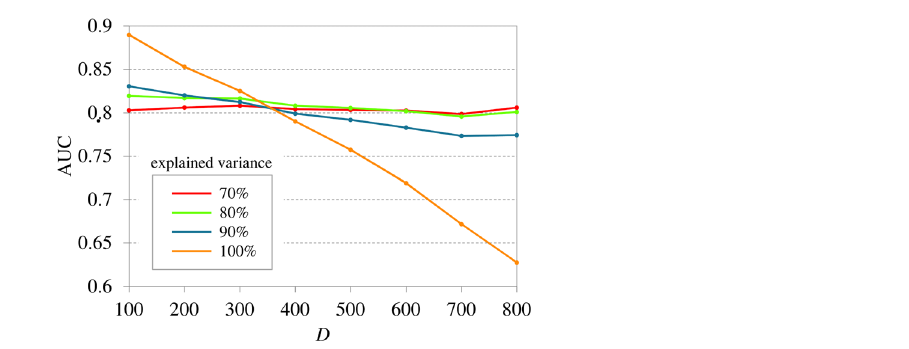
Fig 4. The lsGCI results for synthetic data: mean area under ROC curves (100 realizations) for several dimensions D = 100,200,300,400,600,800, N = 1000, and various variance explanations. The maximum standard error of all estimations equals 0.0023, which is too small to be plotted. A variance explanation of 100% corresponds to the classical GCI, whereas all other shown variance explanations correspond to the lsGCI.